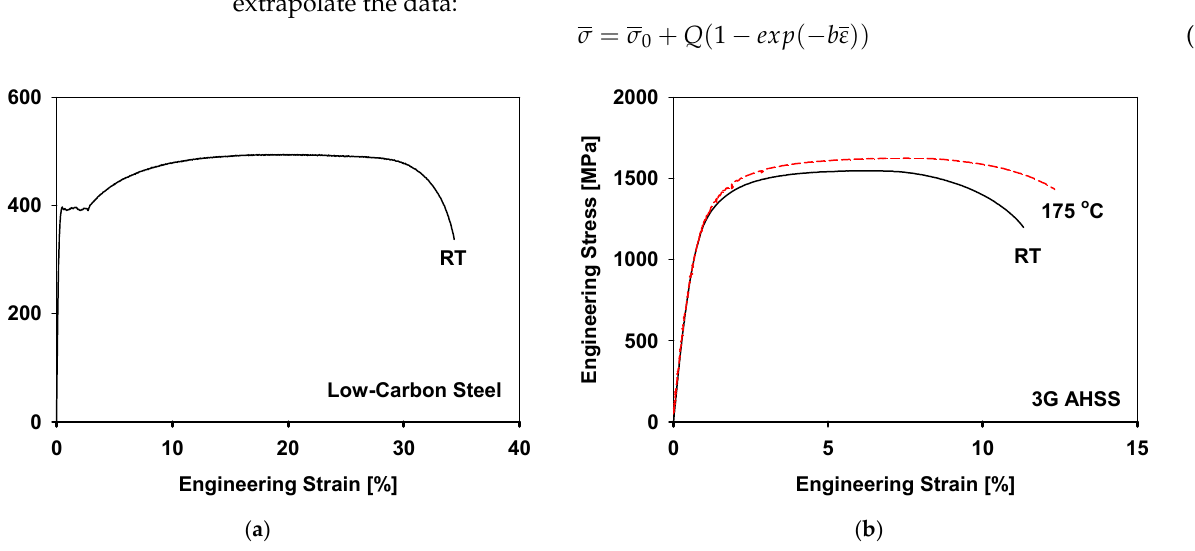
Figure 5. Engineering stress–strain curves of the sheet materials: ( a ) the low-carbon steel and ( b ) the 3G AHSS. Table 2. Tensile properties and hardening